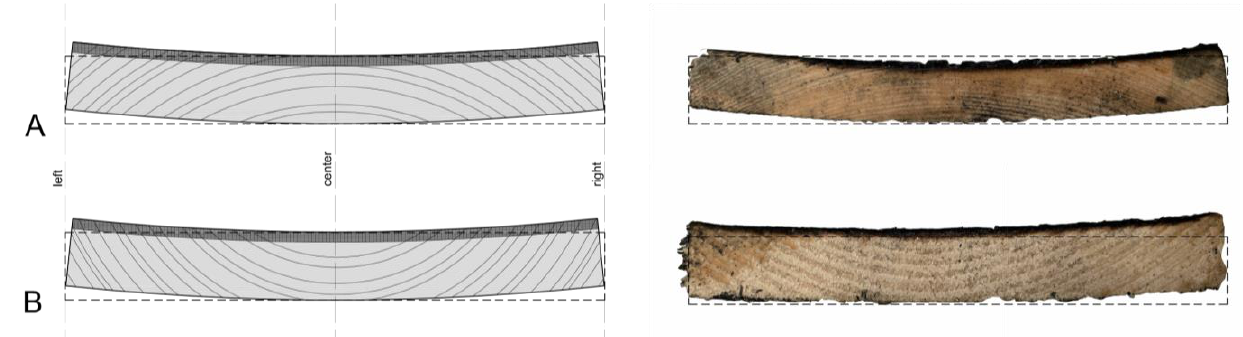
Figure 8. Illustration of the cross section (24 ×190 mm) of spruce ( A ) and fir samples ( B ).